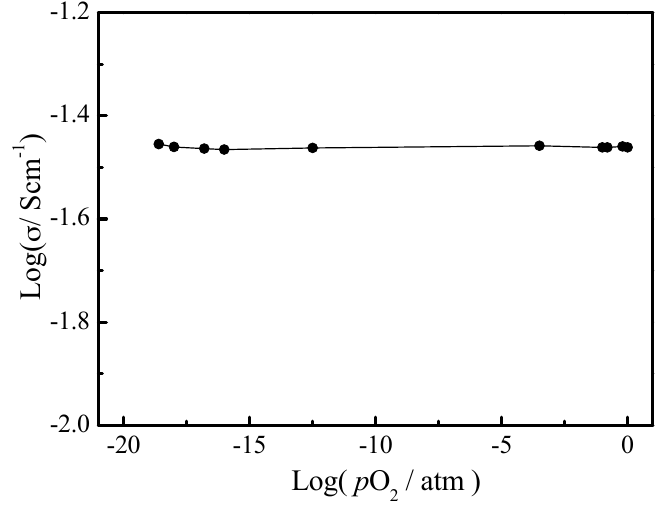
Figure 6. The conductivities of the 8YSZ-20% glass (700 °C) composite electrolyte as a function of p O 2 at 750 °C is almost a pure ionic conductor.